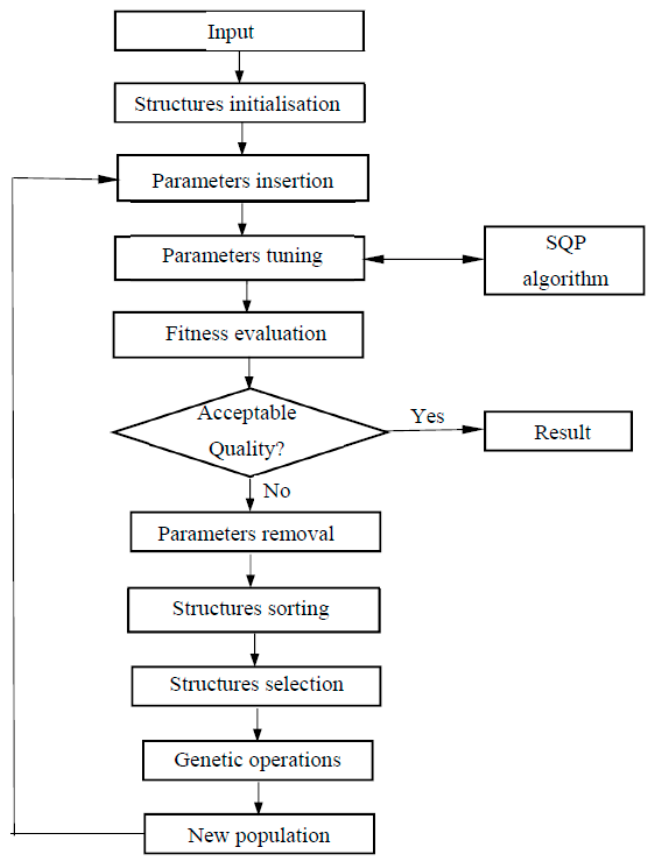
Figure 4. Flowchart of GP (Genetic Programming) methodology.